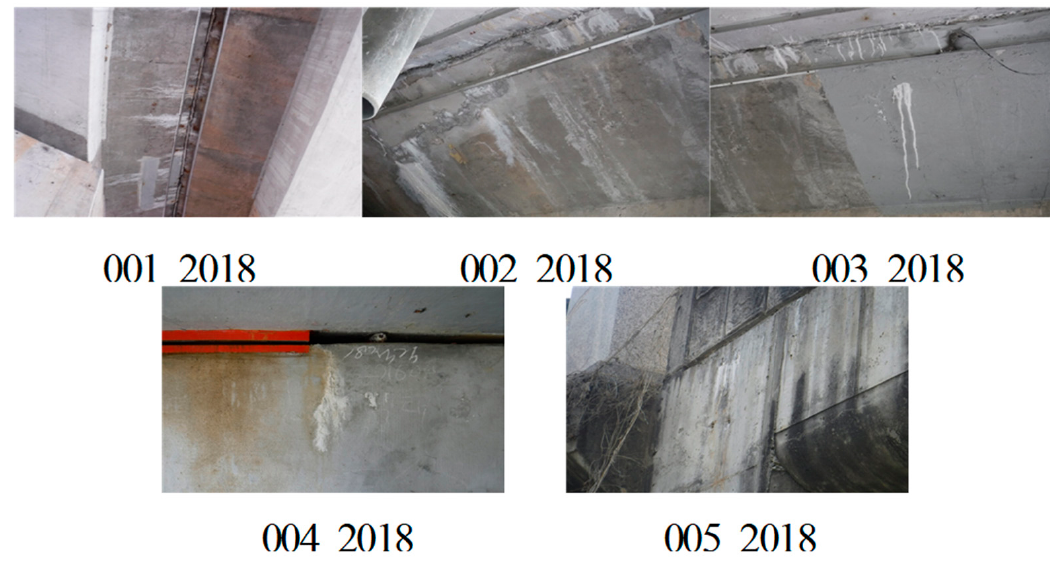
Figure 8. Real bridge image set.